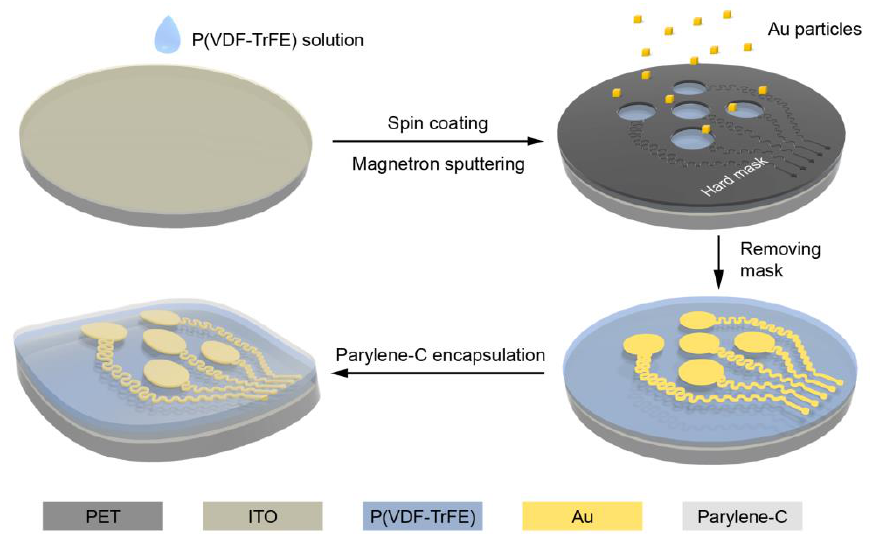
Figure 2. Fabrication process of the cross-shaped sensor array.